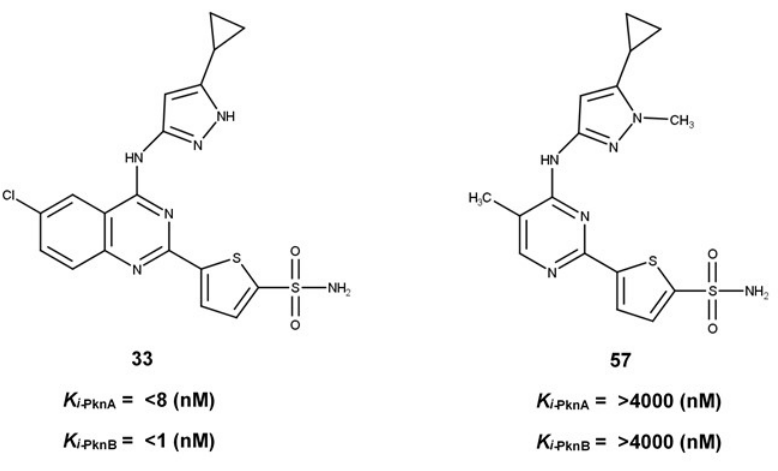
Figure1. Chemicalstructuresof Mtb Ser / ThrProteinkinasesAandBinhibitorswiththeirexperimentally Figure 1. Chemical structures of Mtb Ser/Thr Protein kinases A and B inhibitors with their experimentally reported K i values. reported K i